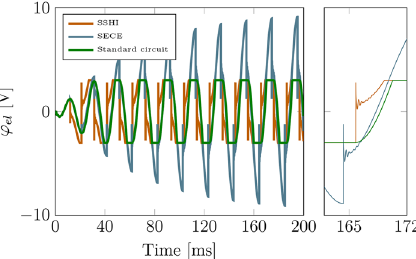
Fig. 10 Electrode voltage 𝜑 el of the bimorph PVEH with standard, SSHI and SECE circuit under a harmonic base acceleration of 1 m/s 2 and a frequency of 48.7 Hz